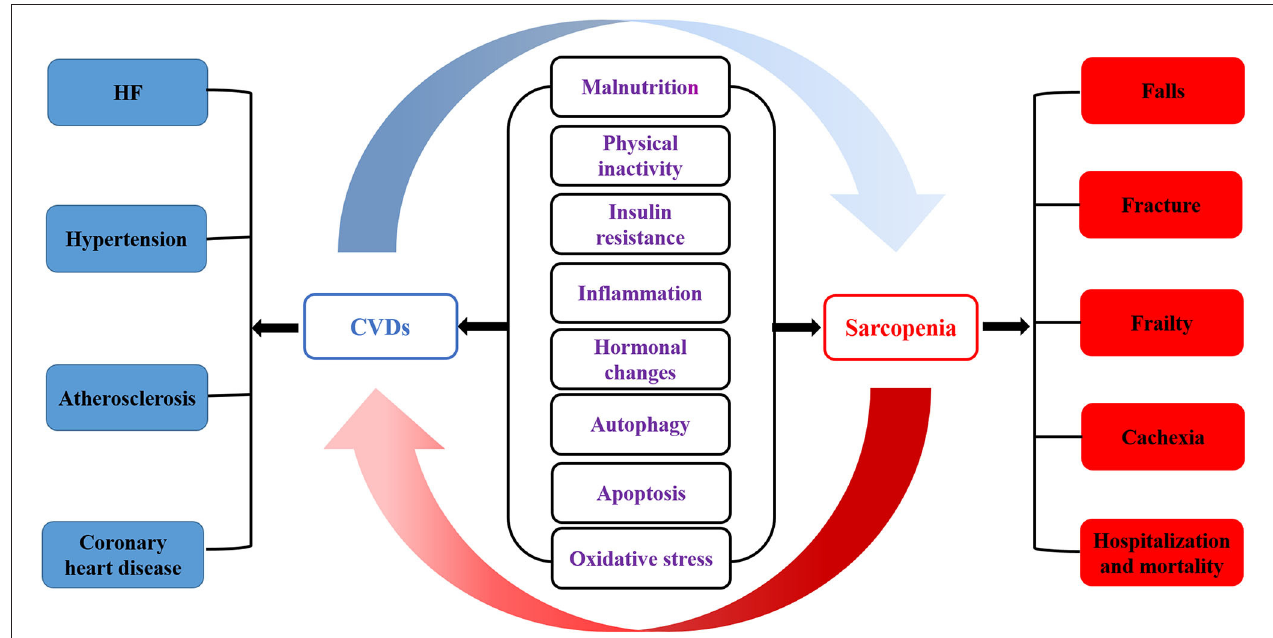
FIGURE 1 | The pathogenesis of sarcopenia and CVDs. Malnutrition, physical inactivity, insulin resistance, inflammation, hormonal changes, autophagy, apoptosis and oxidative stress are involved in the occurrence of CVDs and sarcopenia. Sarcopenia is closely related to cardiovascular disease, which affects each other’s course of disease. In addition, CVDs aggravates the adverse outcomes of sarcopenia, including falls, fracture, frailty, cachexia, hospitalization and mortality. At the same time, the prevalence of CVDs in sarcopenia patients is significantly increased, such as HF, hypertension, atherosclerosis and